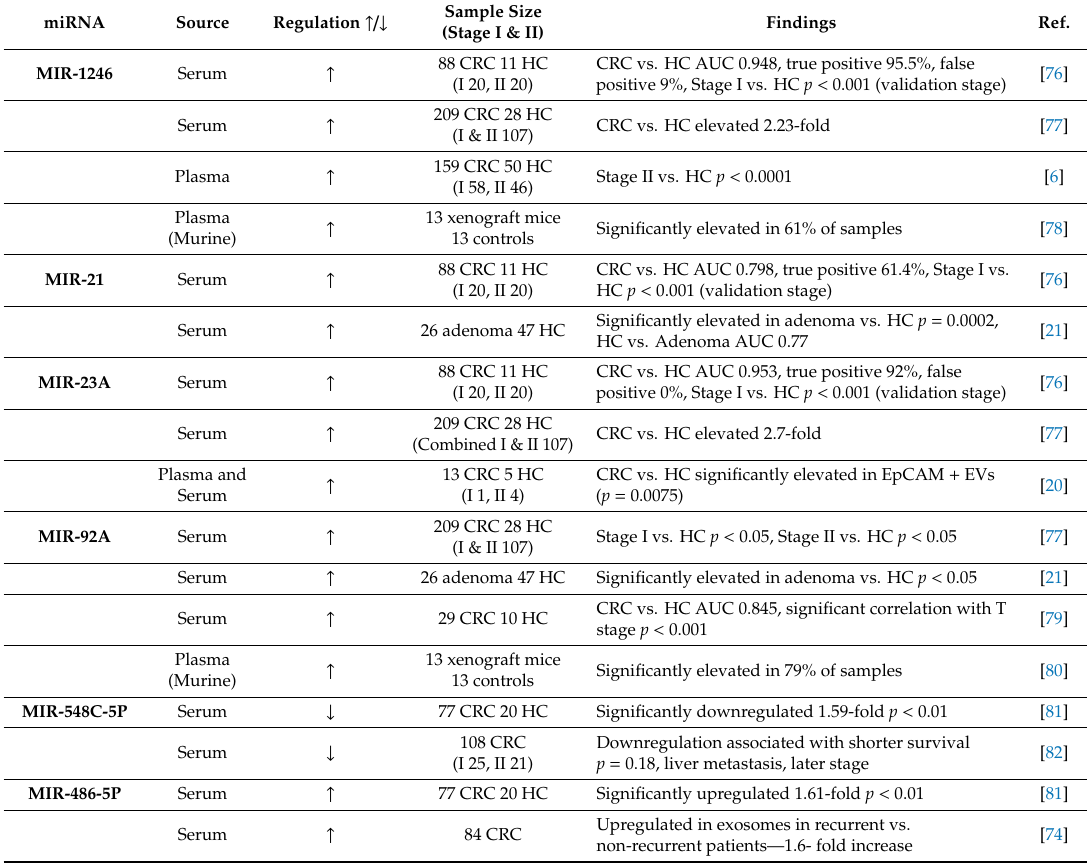
Table 1. Extracellular vesicle (EV)-micro RNAs (miRNAs) in plasma and serum.